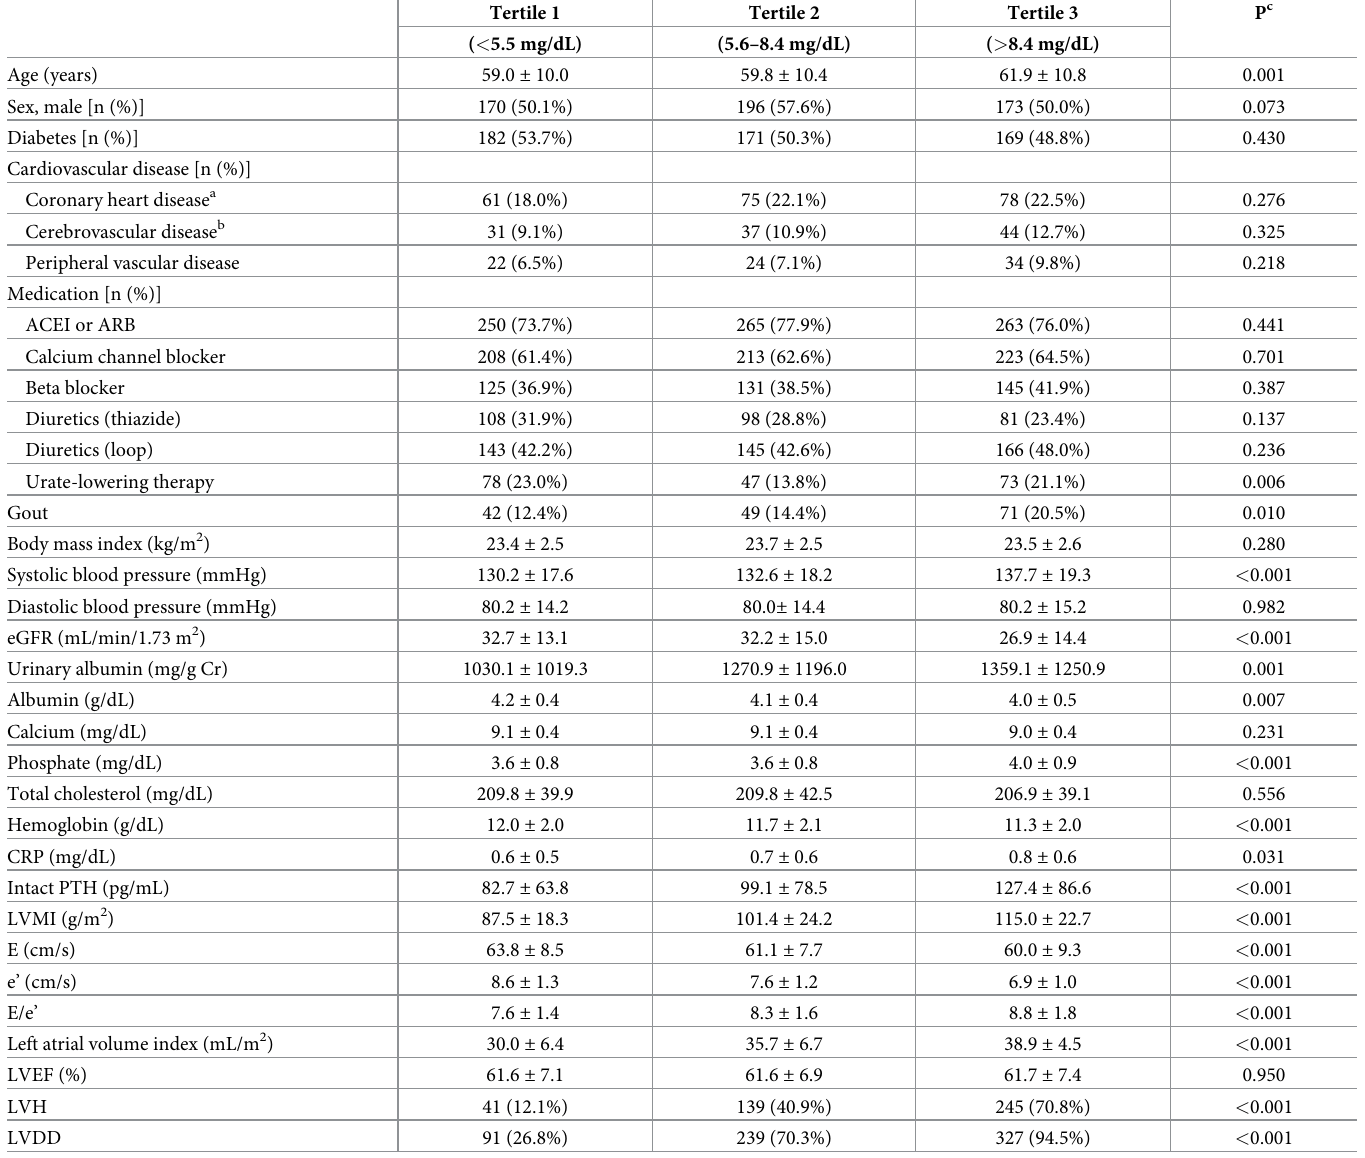
Table 2. Baseline characteristics of the study population according to tertiles of serum uric acid values (n = 1025). Tertile